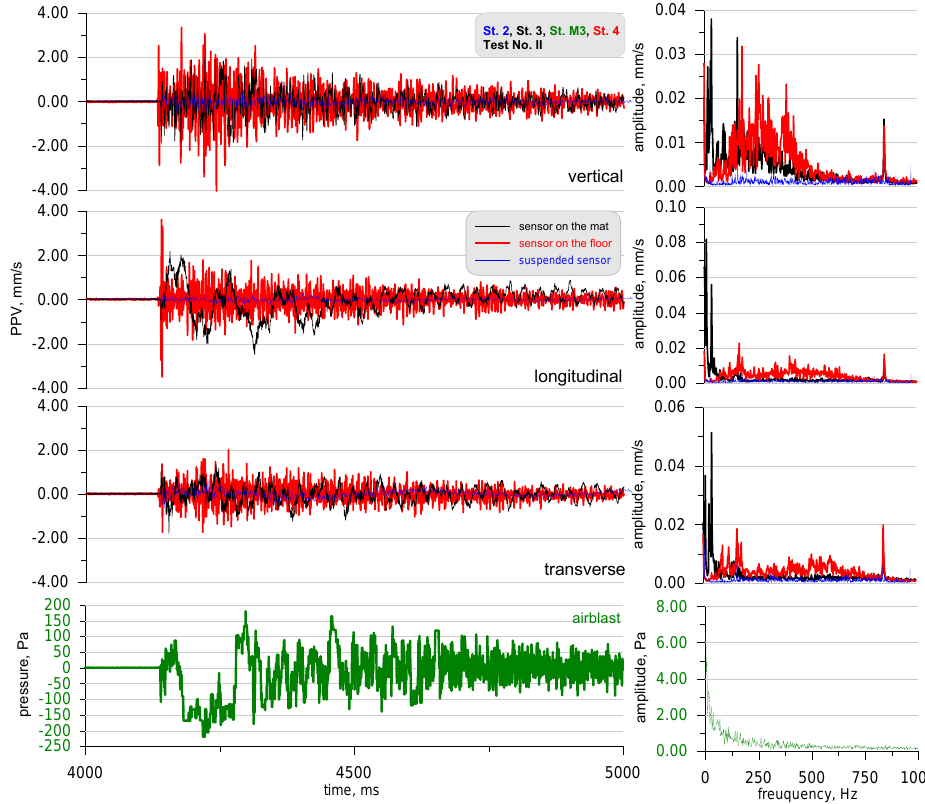
Figure 10. Test No. II: Vibration seismogram (three directional components) and airblast pressure record together with FFT analysis – pyrotechnic material explosion – stand 1, 2 and 4.